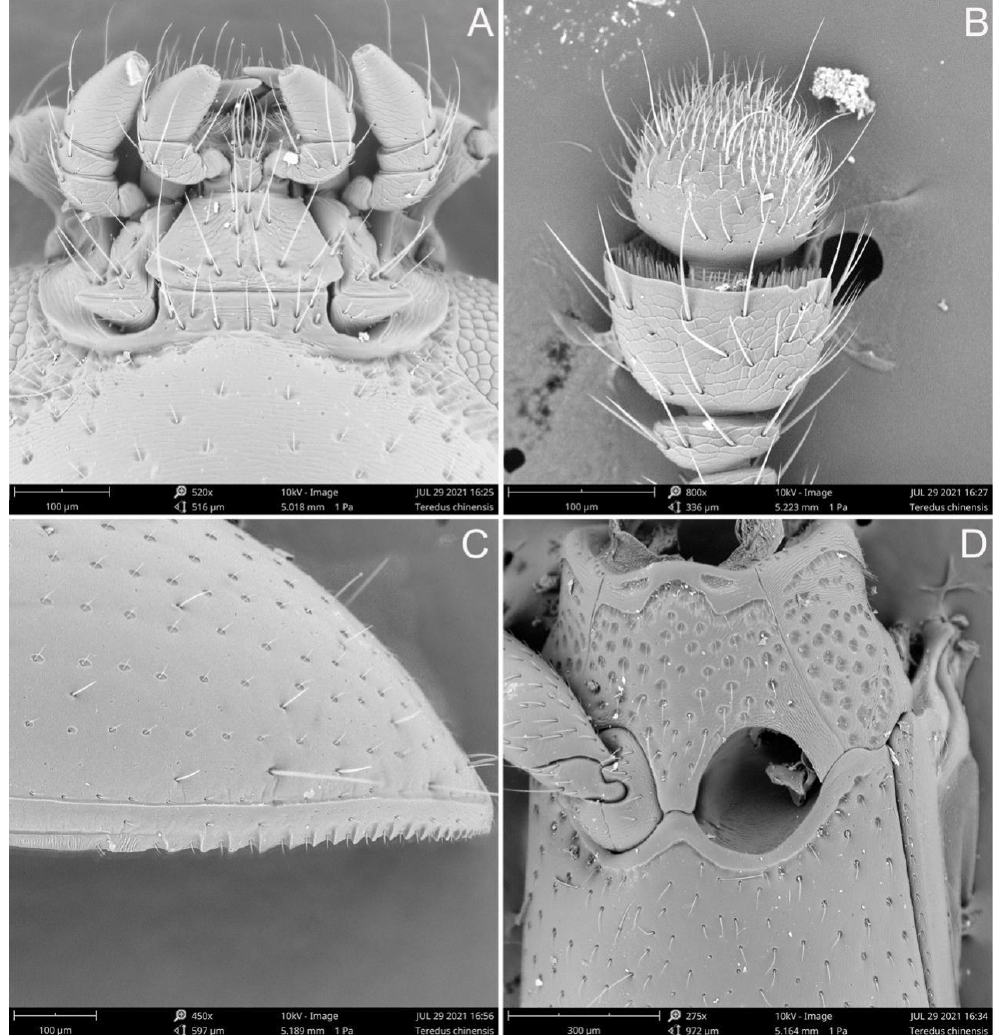
Figure 3. Teredus chinensis sp. nov., paratype, SEM images: ( A ) mouthpart, ventral; ( B ) antennal club; ( C ) apex of outer elytral margin; ( D ) mesoventrite and mesocoxae, ventral.